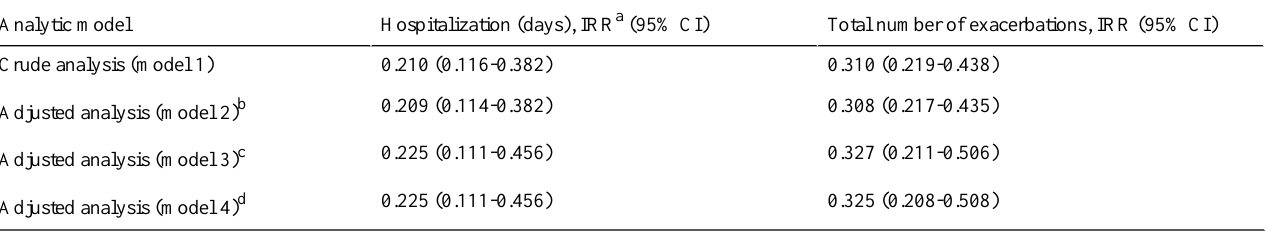
Table 3. Effect of EmmaCOPD on length of hospitalization and number of exacerbations, compared between 365 days before the initiation of EmmaCOPD and 12-18 months after the initiation of EmmaCOPD.